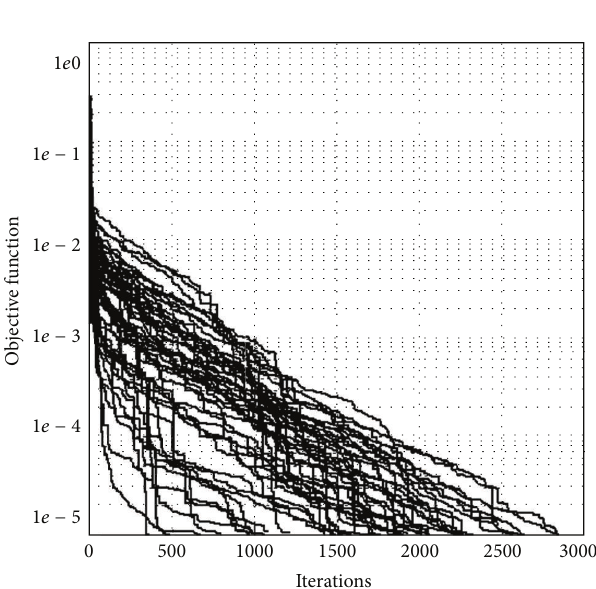
Figure 8: Multiple rounds of repeated tests of objective